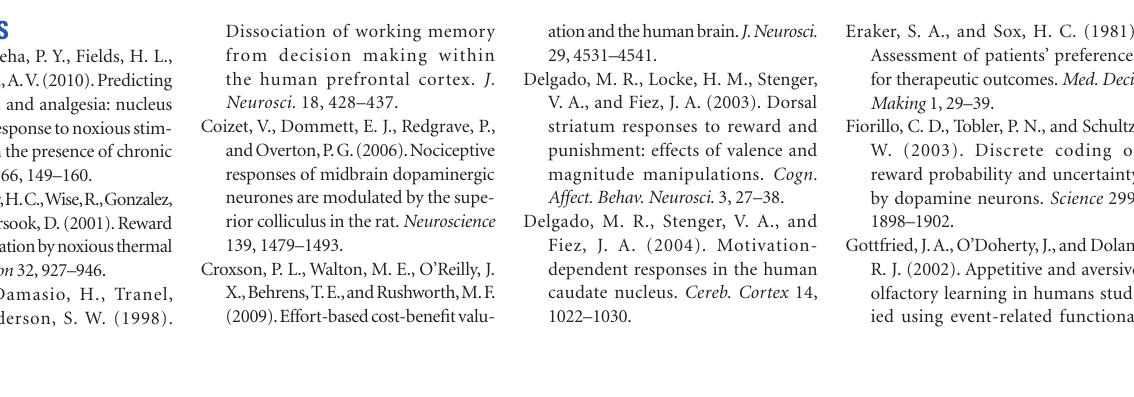
Table 1 | Regions showing BOLD activity that correlates with the expected value of the gamble (eV